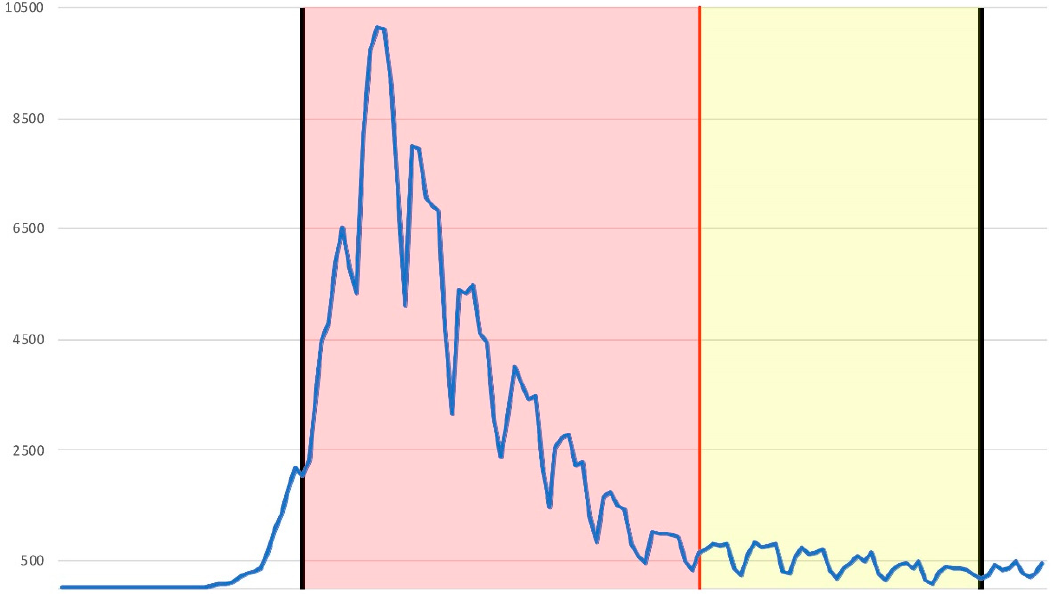
Figure 1. Number of daily COVID-19 diagnosed cases within the first wave of the pandemic in Spain. Grey lines delimit the State of Alarm. Red shadow shows the total-confinement period, and yellow shadow shows the de-escalation period once cases decreased enough.